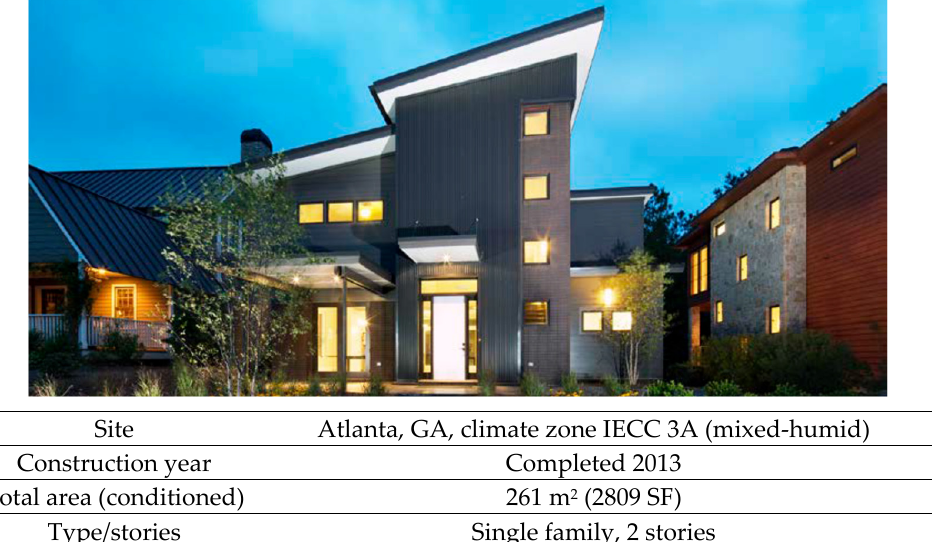
Figure 5. Planning characteristics of building B. Source: DOE (2014) [35].